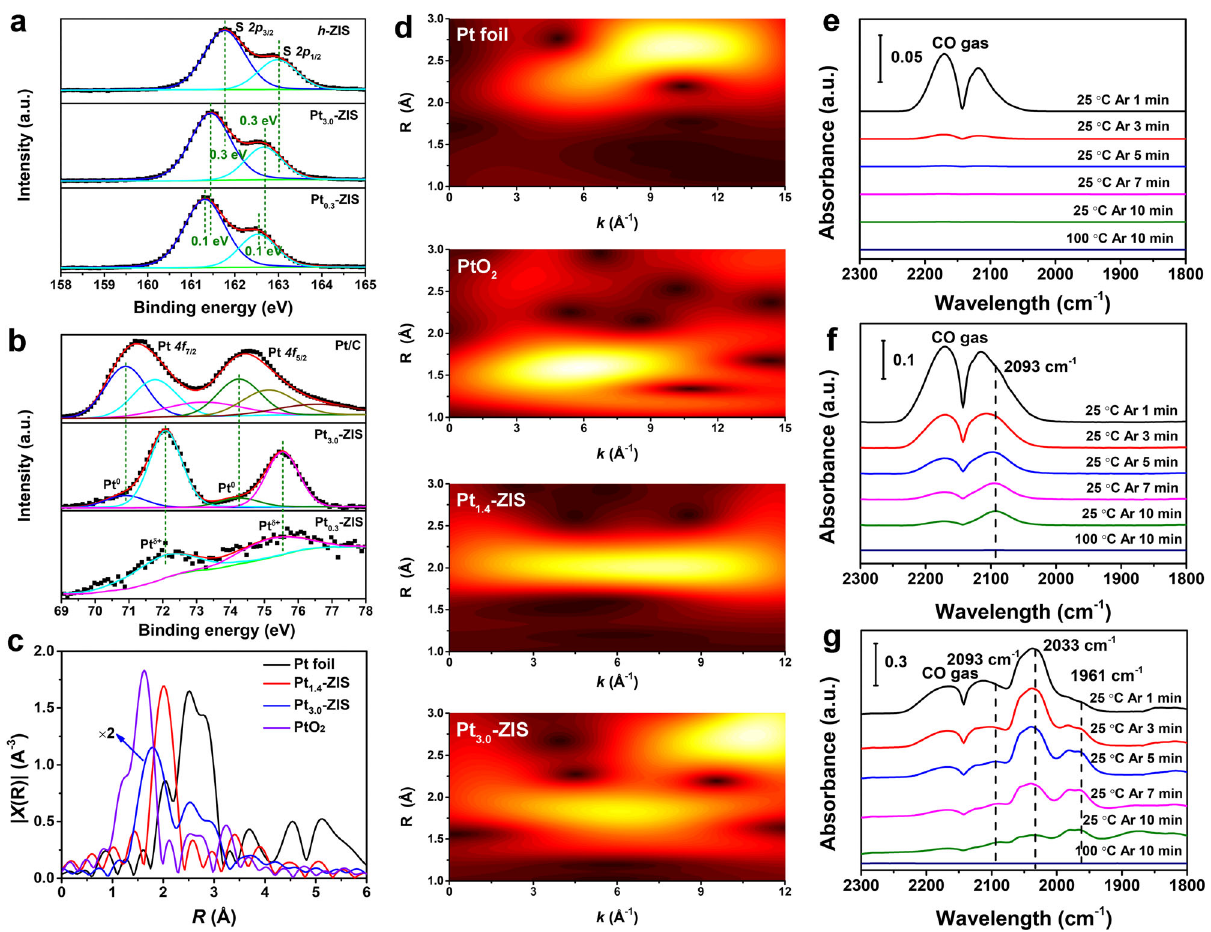
Fig. 2 Electronic states of atoms in photocatalysts. a High-resolution XPS spectra (S 2p ) of h -ZIS, Pt 3.0 -ZIS, and Pt 0.3 -ZIS. b High-resolution XPS spectra (Pt 4f ) of Pt/C, Pt 3.0 -ZIS, and Pt 0.3 -ZIS. c Fourier transform of k 2 -weighted Pt L 3 -edge of the EXAFS spectra for Pt foil, PtO 2 , Pt 1.4 -ZIS, and Pt 3.0 -ZIS.